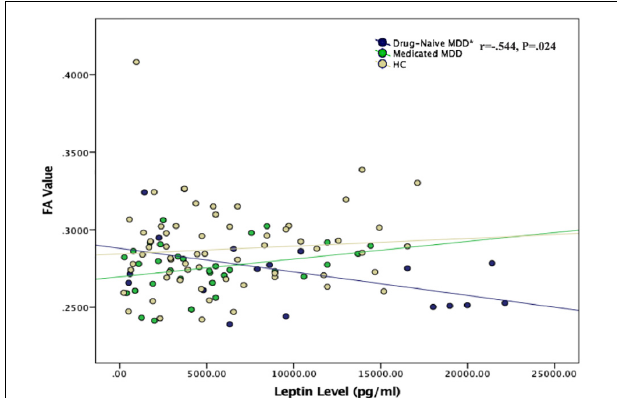
FIGURE 2 | Scatter plot of the correlation between plasma leptin levels and FA values in all study groups. ∗ Negative correlation was found between plasma leptin level and FA value in the left thalamus region in drug-naïve MDD group ( P = 0.024). No correlation was found for the medicated MDD and healthy control